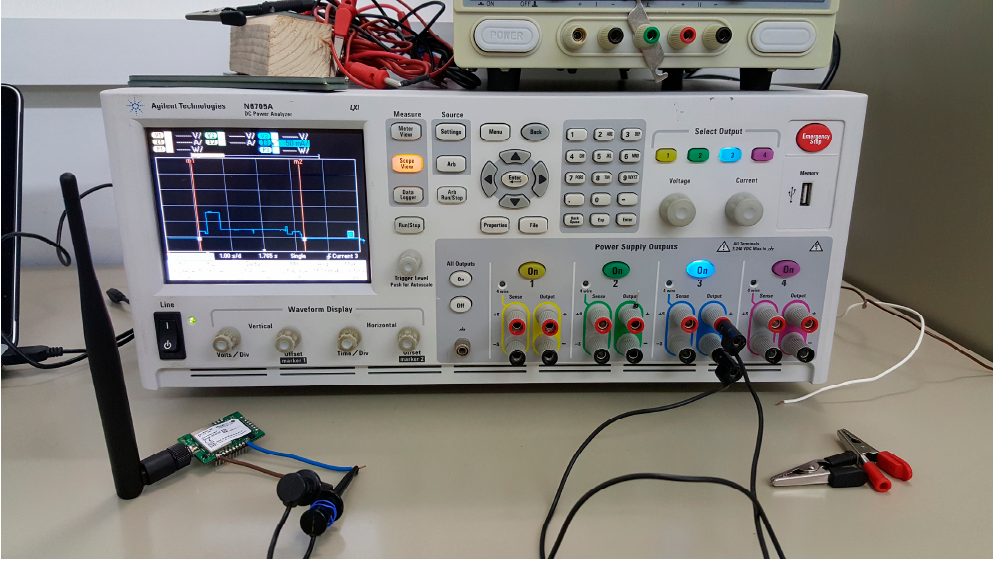
Figure 5. Experimental setup for current measurements of the MultiConnect mDot LoRaWAN end-device module (on the left) using an Agilent N6705A power analyzer.